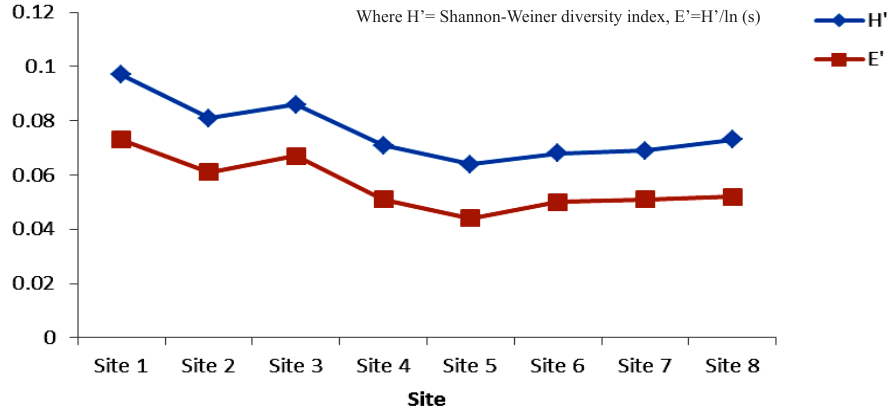
Figure 1. Shannon diversity index and evenness of birds in Overa-Aru Wildlife Sanctuary